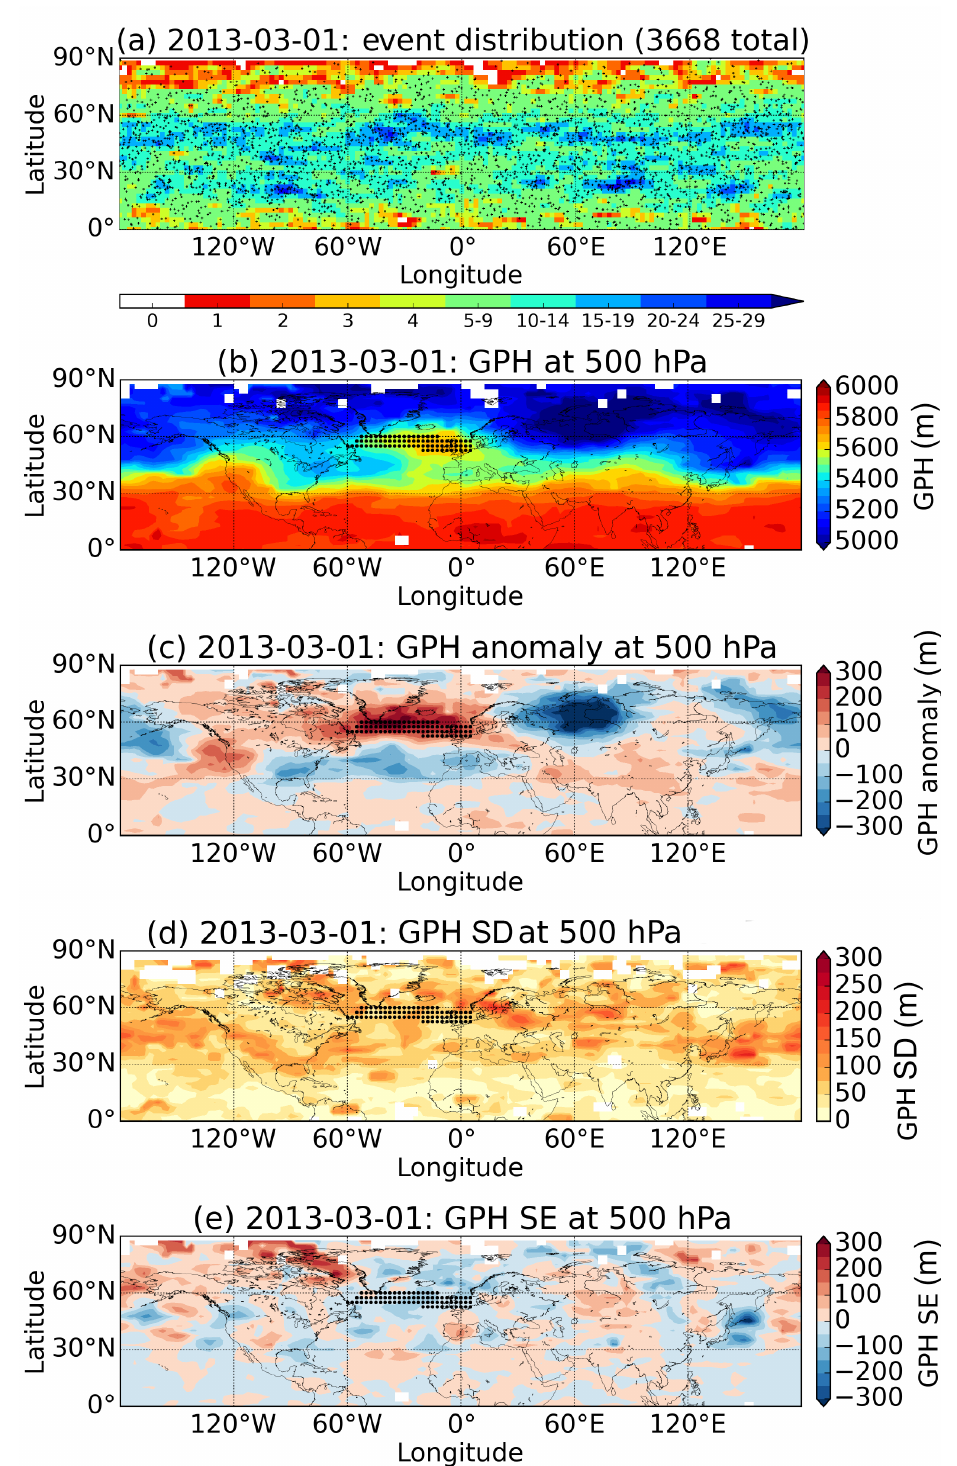
Figure 2. Same layout as Fig. 1 but for an exemplary day during the Greenland